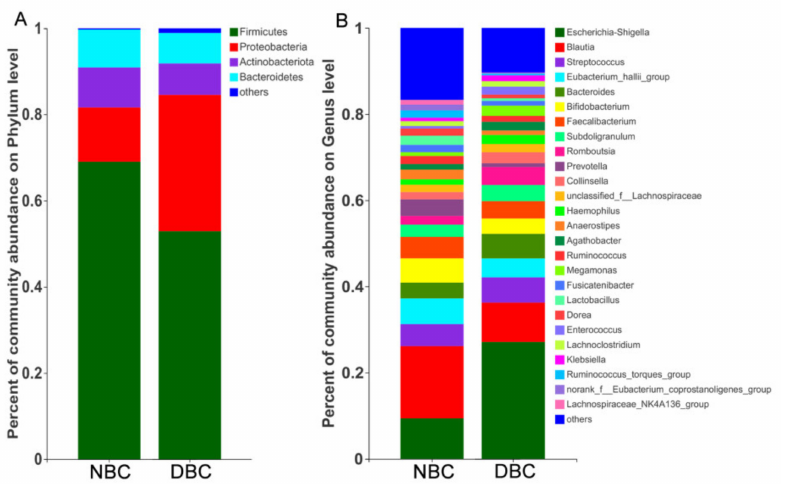
Figure 3. Gut microbiota composition in depressed and non-depressed breast cancer patients. ( A ) The community structures of different microbes at the phylum level. ( B ) The community structures of different microbes at the genus level. DBC, depressed breast cancer patients ( n = 18); NBC, non- depressed breast cancer patients ( n =